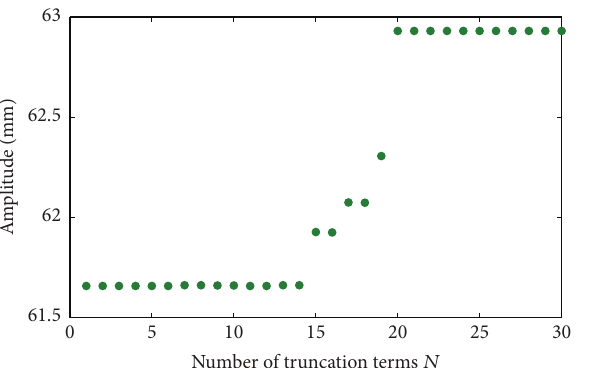
Figure 2: Effects of the number of Galerkin truncation terms on transverse displacements of the midpoint of the deck beam when there are no geometric nonlinear